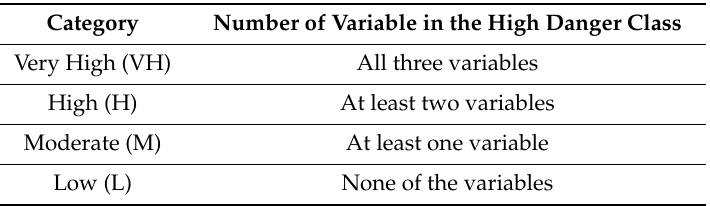
Table 3. The categorization criteria (i.e., the total number of variables occurred in the high danger class) that were followed to define the fire danger classes in the integrated forest fire danger